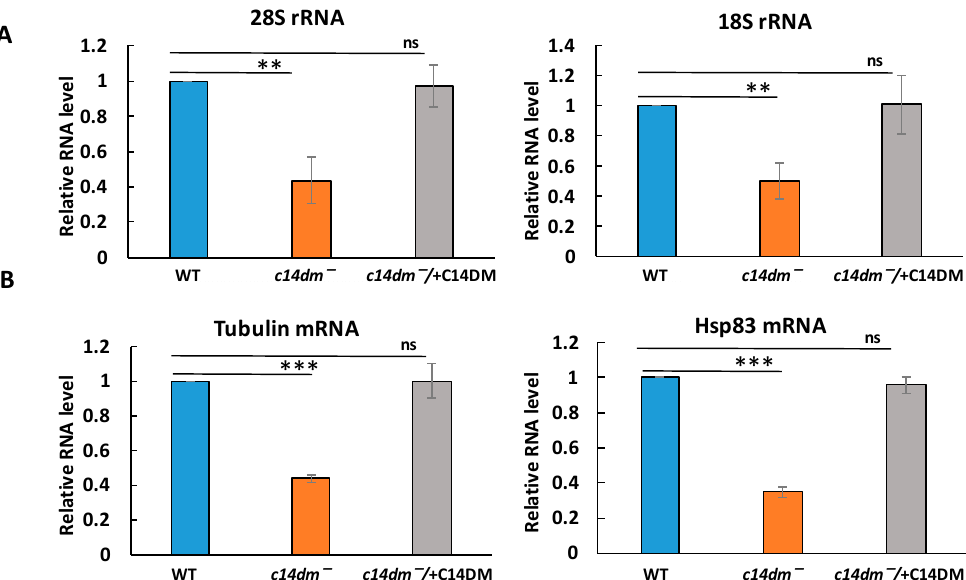
Figure 2. Levels of ribosomal RNA and individual mRNAs are reduced in c14dm − . The total RNA was extracted from 1 × 10 7 cells of WT, c14dm − and c14dm − / + C14DM cells. The artificial outer membrane protein A (OmpA) mRNA was added prior to RNA extraction for further normalization. RNA levels were measured by RT-qPCR. ( A ) 28S (left panel) and 18S (right panel) rRNA levels. ( B ) Tubulin (left) and HSP83 (right) mRNA levels. ns: not significant; **: p < 0.01; and ***: p < 0.001.